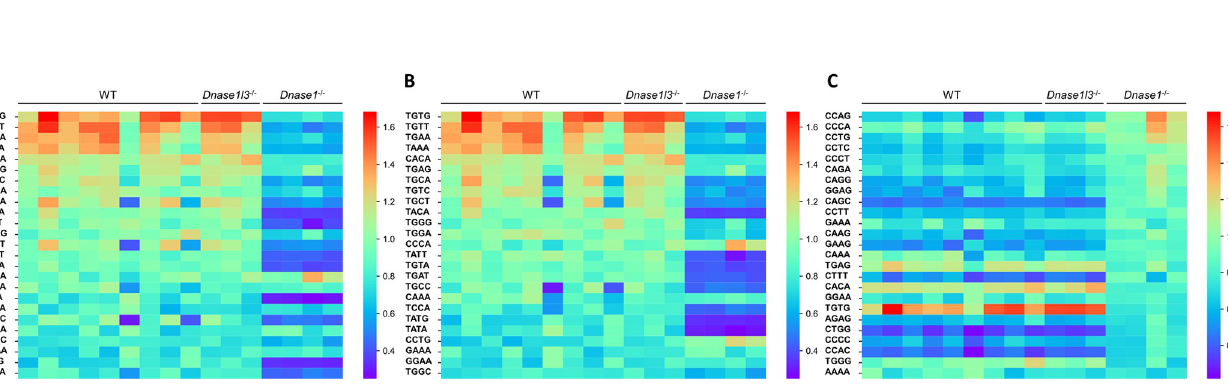
PLOS Genetics | https://doi.org/10.1371/journal.pgen.1010262 July 6, 2022 5 /